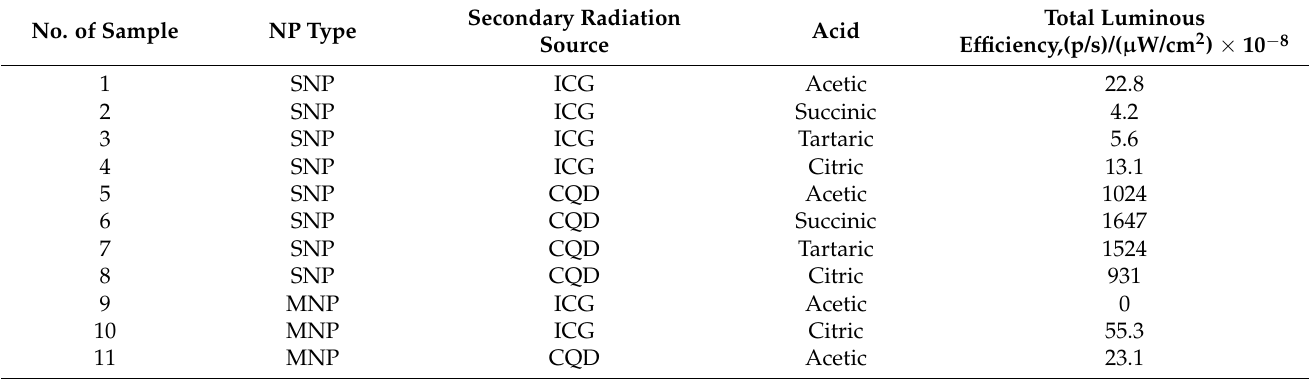
Table 5. Measured values of luminous efficiency of fluorescent radiation of samples.